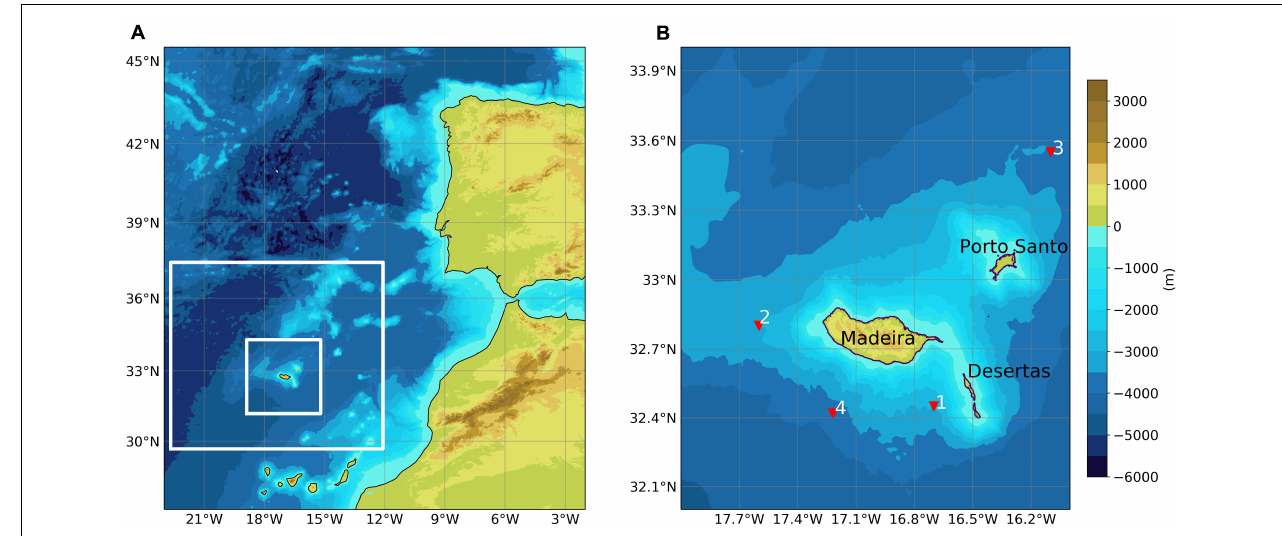
FIGURE 1 | Topography retrieved from Shuttle Radar Topography Mission (SRTM) and sea floor bathymetry near Madeira Island retrieved from General Bathymetric Chart of the Oceans (GEBCO). In panel (A) , white rectangles indicate geographical limits of the two domains used in Weather-Research and Forecasting (WRF) and Regional Oceanic Modeling System (ROMS): 9 km (outer) and 3 km resolution (inner), and in panel (B) , red triangles indicate locations where some analysis is done.